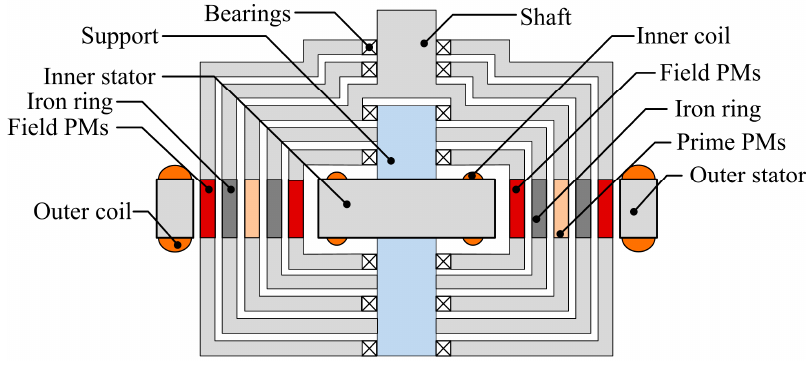
Figure 2. Mechanical structure of double-stator magnetic geared permanent magnet generator.